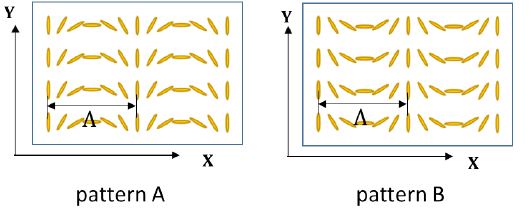
Figure 1. Photoalignment patterns A and B to diffract circularly polarized light efficiently. Pattern A diffracts left-handed circularly polarized incident light towards the